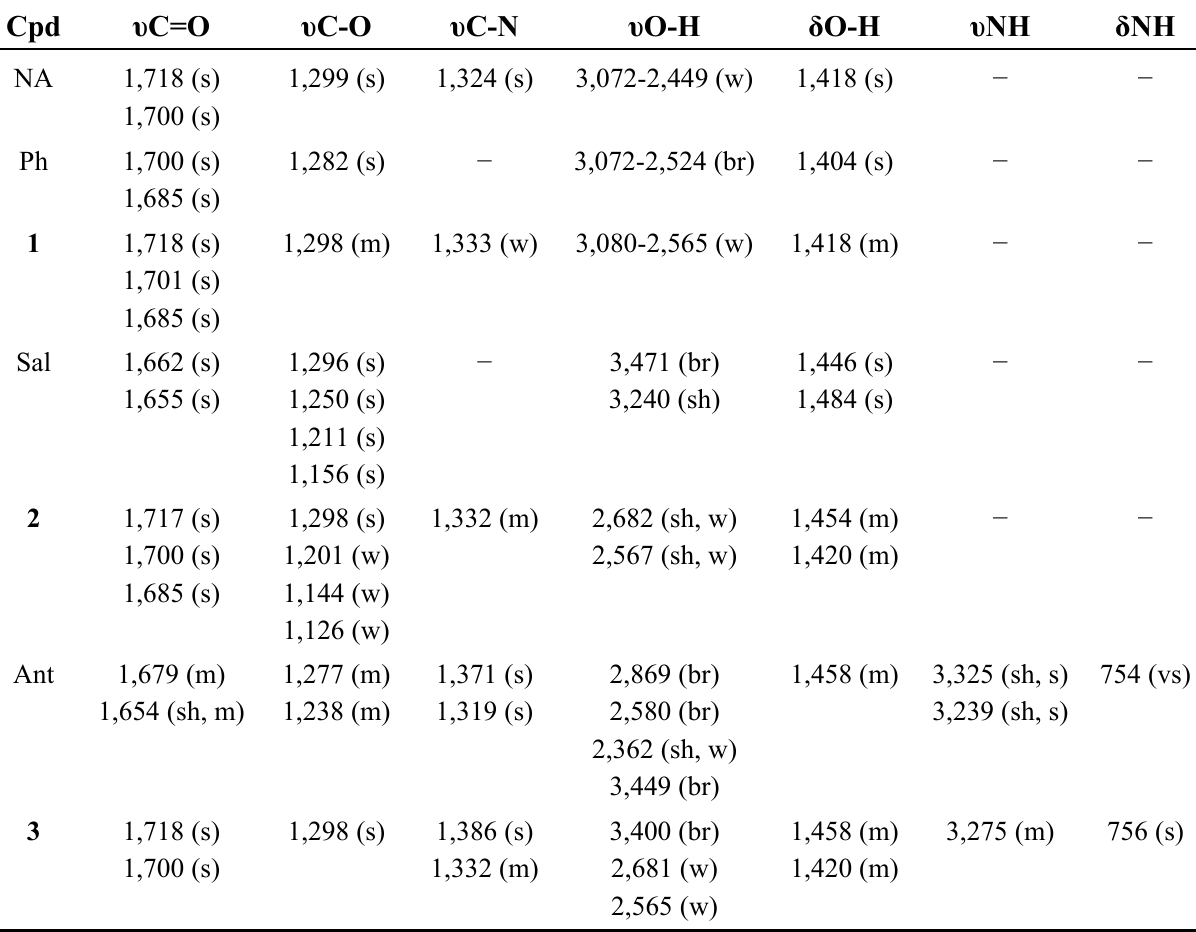
Table 2. IR spectra of the free ligands and the copper coordination